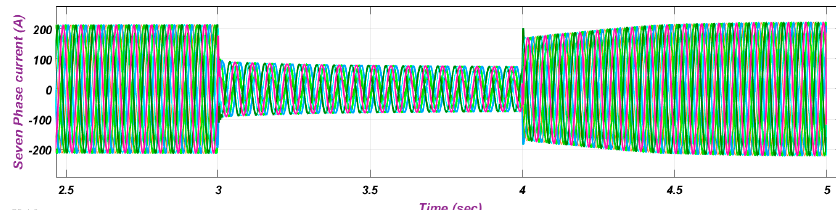
Figure 9. Fault Current of 7 P IG with One Phase Open ( V c ). Figure 10. Fault Current of 7 P IG with Two Phases Open ( V c and V d ). Figure 10. Fault Current of 7 P IG with Two Phases Open ( V c and V d ). Figure 10. Fault Current of 7PIG with Two Phases Open ( V c and V d ).